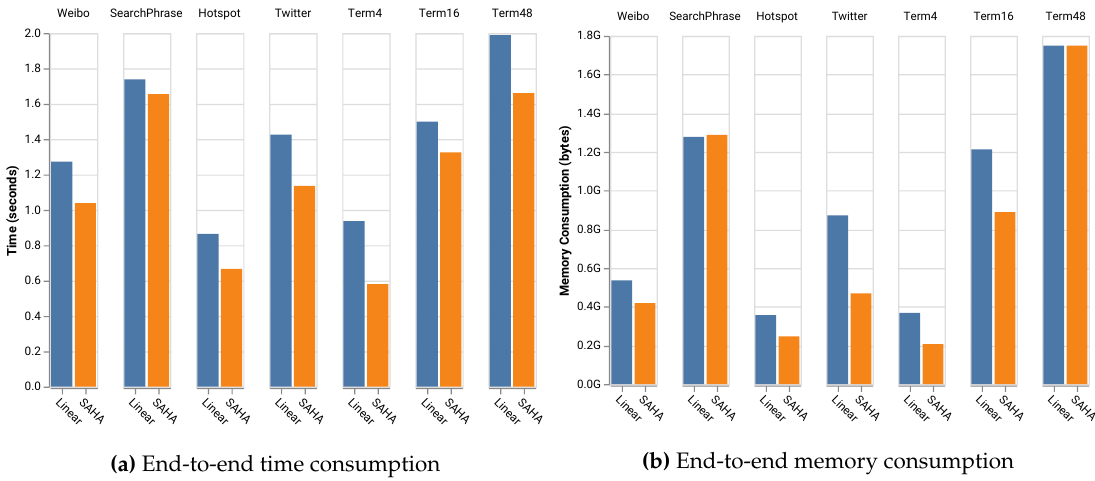
Figure 15. Two bar graphs of the time and memory consumption of ClickHouse ’s builtin hash table and SAHA with pre-hashing enabled for an end-to-end group query benchmark on various